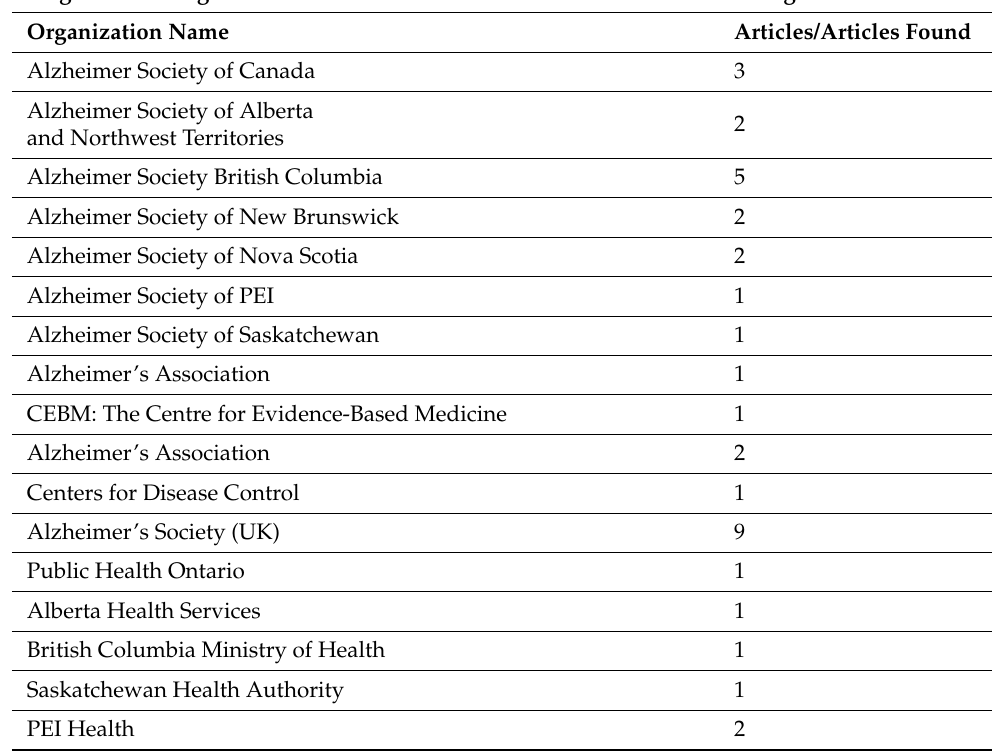
Table A4. Grey literature articles identified with articles of